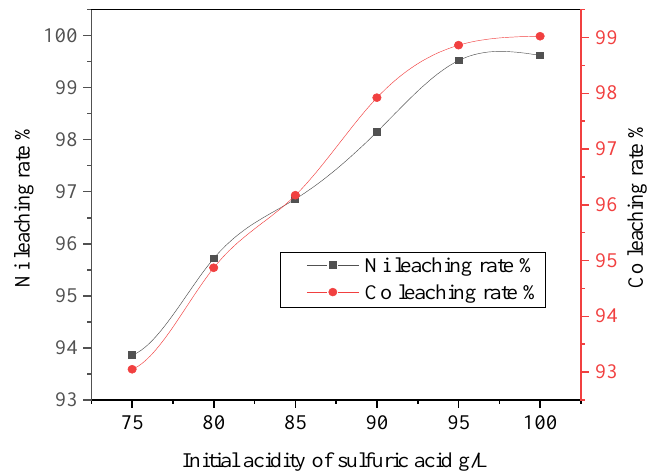
Figure 3. Influence of initial sulfuric acid concentration on the leaching rates of nickel and cobalt.